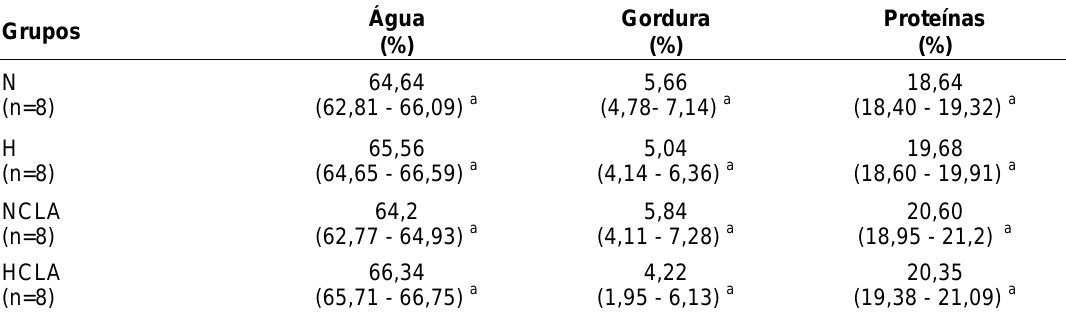
Tabela 5. Composição corporal dos camundongos Apo E